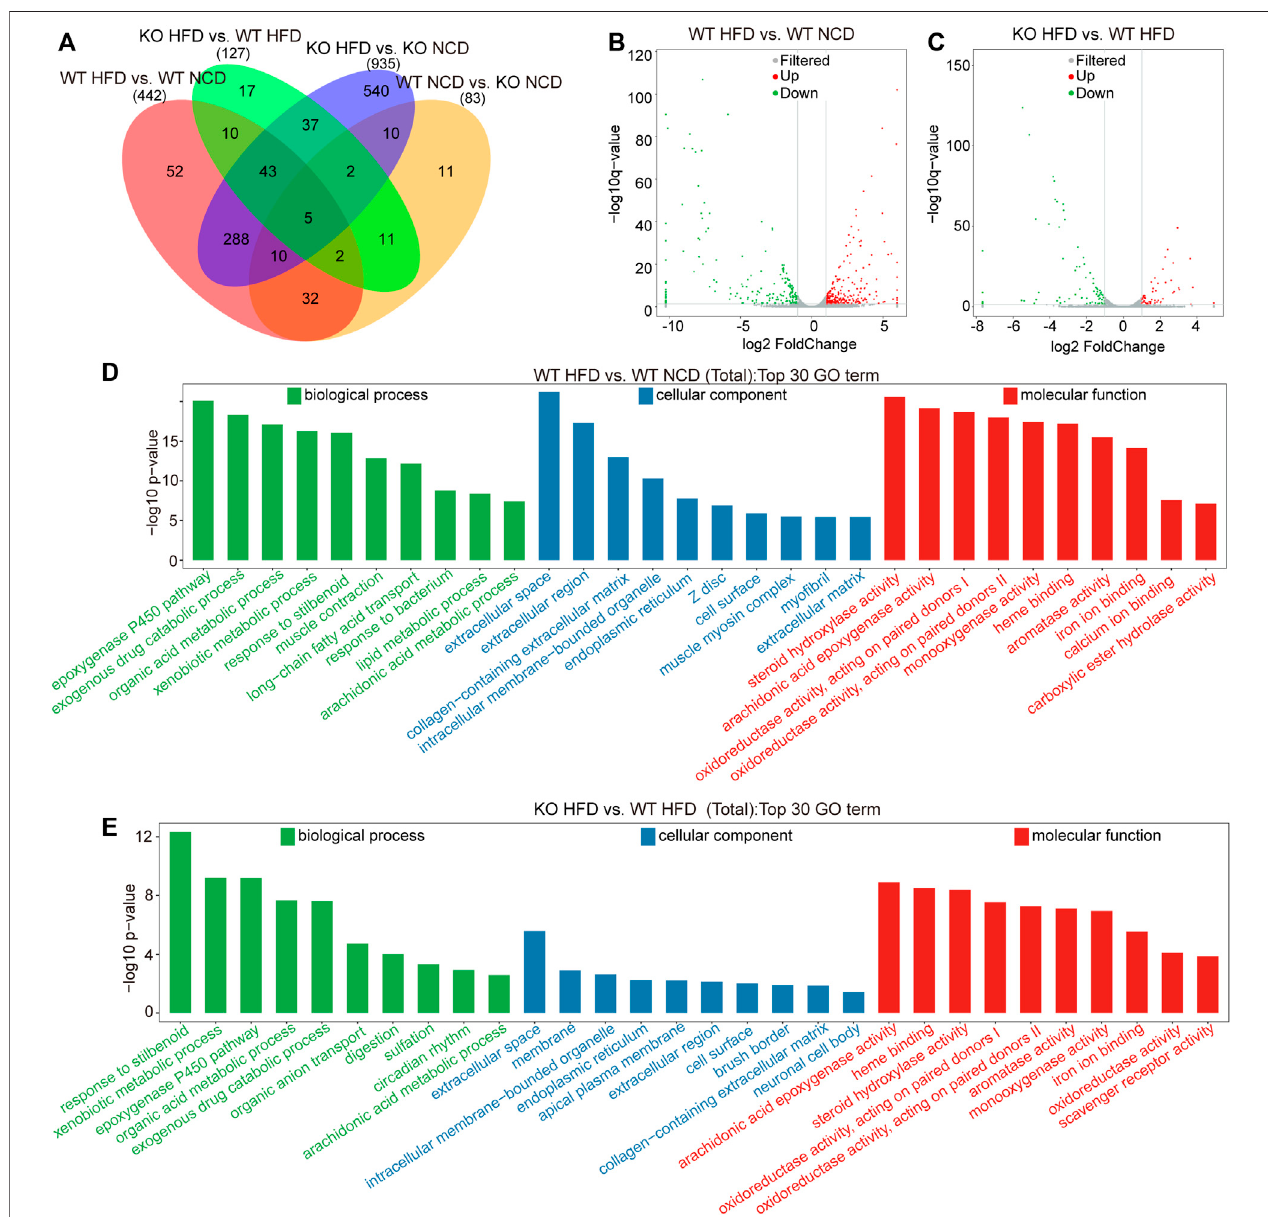
FIGURE 3 | Transcriptome analysis of the liver tissues of the four subgroups. (A) Comparative analysis of differentially expressed genes among four groups. (B) Volcano plot of differential genes between WT-HFD mice and WT-NCD mice. The gray represented for non-signi fi cant difference genes, red and green are signi fi cant difference genes. (C) Volcano plot of differential genes between CD1d KO − HFD mice and WT-HFD mice. (D) The top 30 signi fi cantly enriched GO annotations between WT-HFD and WT-NCD mice. (E) The top 30 signi fi cantly enriched GO annotations between CD1d KO-HFD and WT-HFD mice. GO, gene ontology; HFD, high-fat diet; KO, knockout; NCD, normal control diet; WT, wild-type.